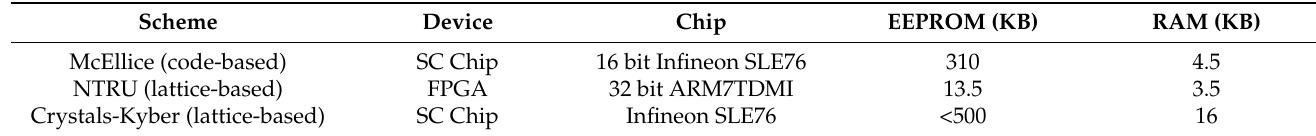
Table 4. PQC Algorithms RAM and Processor minimal requirements suitable for Secure